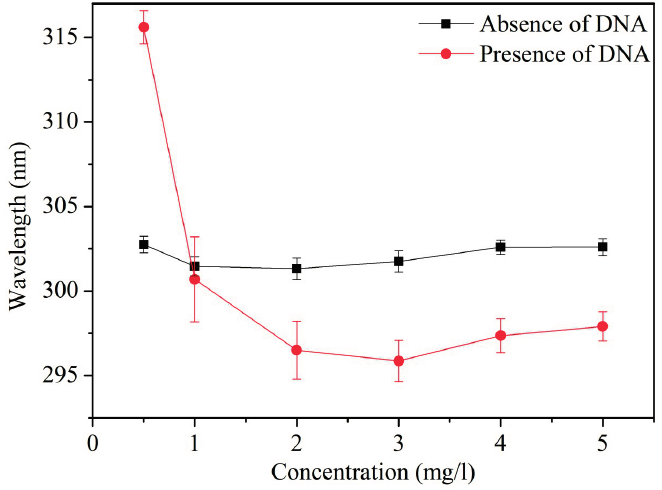
Figure 1. Peak shift of dye in presence and absence of DNA. Each data point in the graph denotes Mean ± Standard